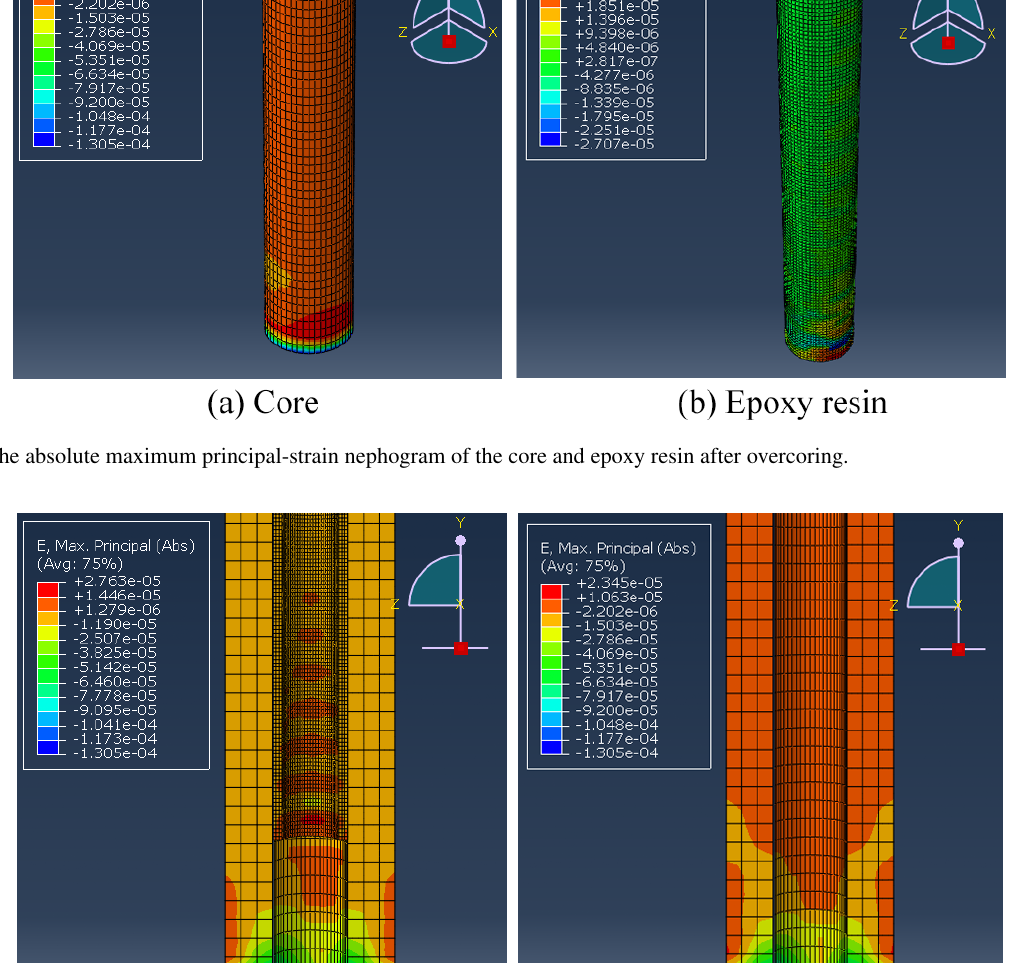
variables in stress inversion calculation, and the results of in situ stress inversion calculation are shown in Table